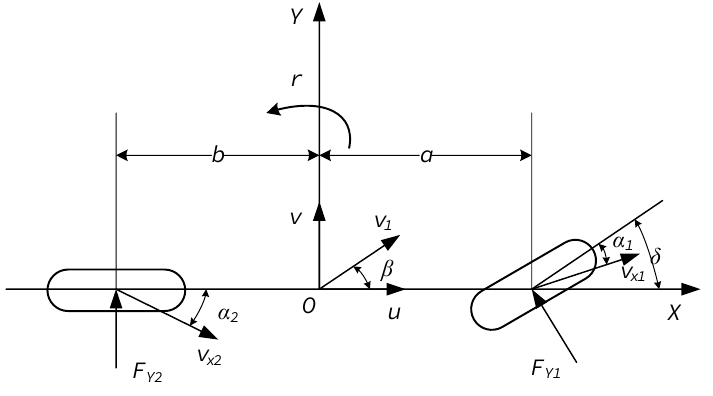
Figure 1. 3-DOF vehicle model.